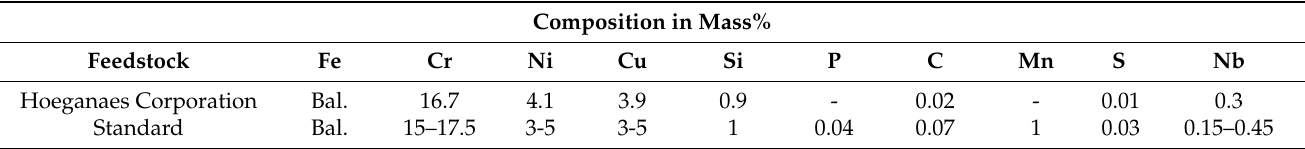
Table 1. Chemical compositions of the 17-4PH powder employed as feedstock. Composition in